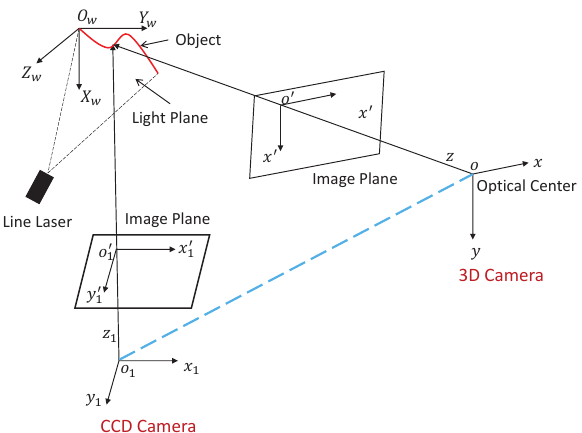
Figure 5: The relationships between the coordinate systems of the CCD image and 3D data, which include two image coordinate systems ( o ′ − x ′ y ′ and o ′ 1 − x ′ 1 y ′ 1 ), two image space coordinate systems ( o − xyz and o 1 − x 1 y 1 z 1 ), and one object space coordinate system ( O w − X w Y w Z w